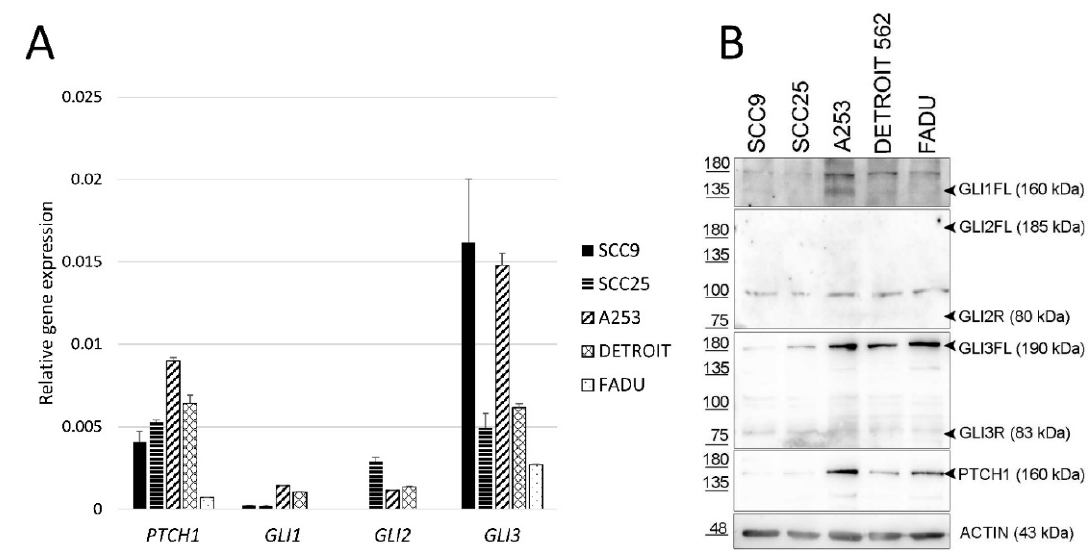
Figure 1. Gene and protein expression of HH-GLI pathway components in HNSCC. ( A ) Relative gene expression of PTCH1 , GLI1 , GLI2, and GLI3 determined by quantitative Real-Time Polymerase Chain Reaction (qRT-PCR). Gene expression is shown relative to the level of the housekeeping gene RPLP0 . ( B ) Protein expression determined by Western blot. FL refers to the full-length protein (activator form), while R refers to the repressor form.